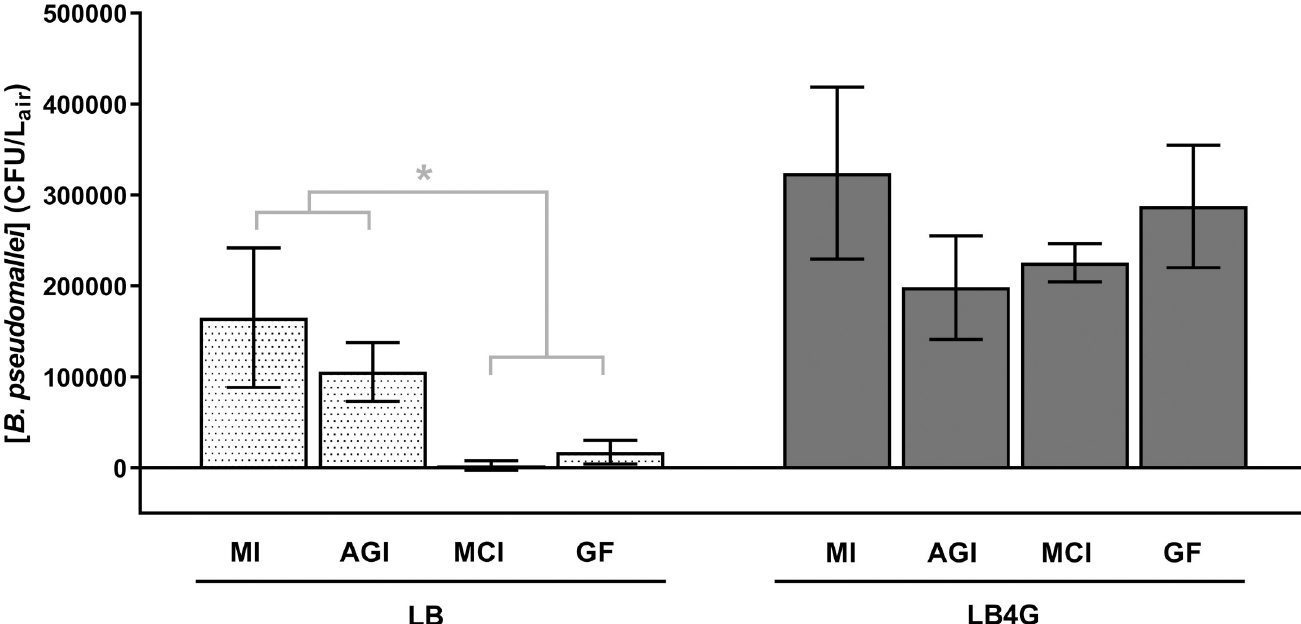
Fig 3. B . pseudomallei aerosol concentrations. For aerosols generated from B . pseudomallei suspended in LB, the Mercer cascade impactor and gelatin filter measured significantly lower aerosol concentrations than the AGI and midget impingers. However, for aerosols generated from B . pseudomallei suspended in LB4G, all four samplers performed equivalently. Significant differences by Tukey’s multiple comparisons post-test are indicated by an asterisk. MI = midget impinger, AGI = All Glass Impinger, MCI = Mercer cascade impactor, GF = gelatin filter.